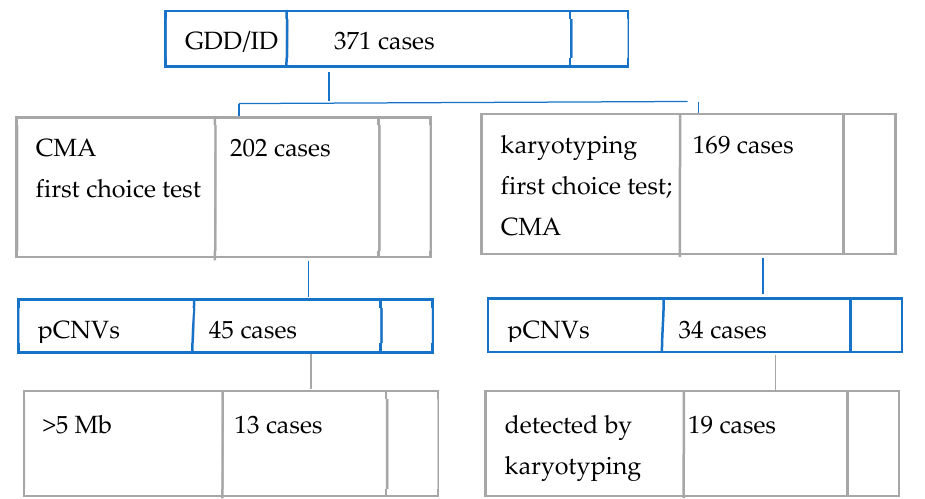
Figure 1. Diagnostic workflow and findings in our cohort.